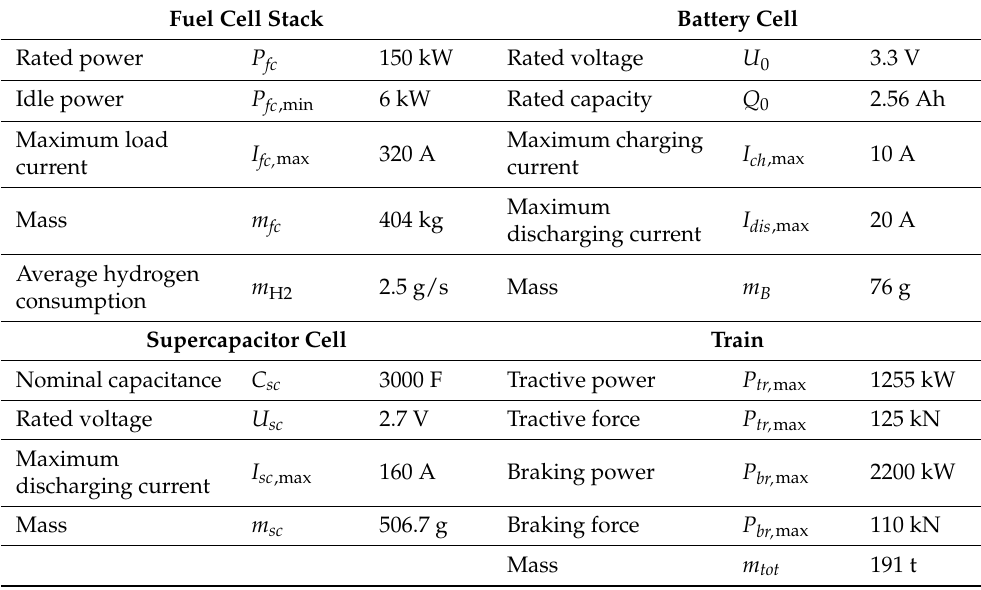
Table 2. Power sources properties.